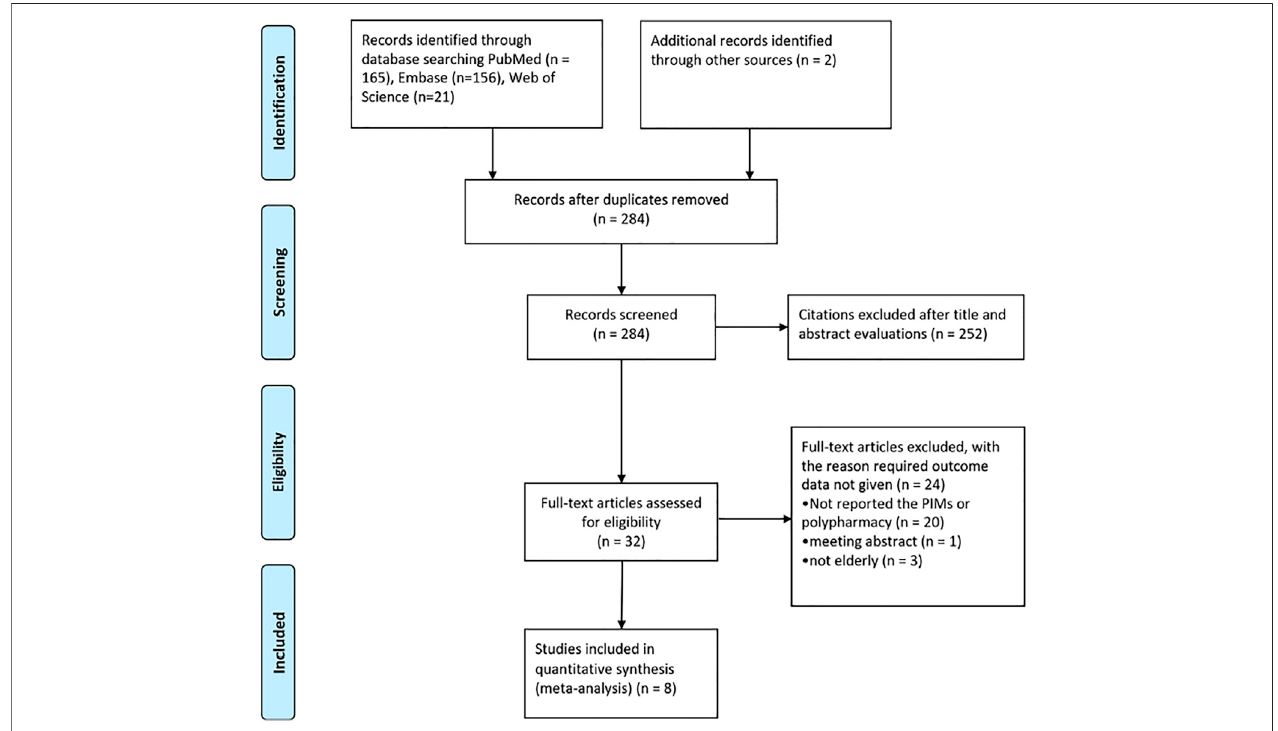
FIGURE 1 | Diagram of the literature selection.